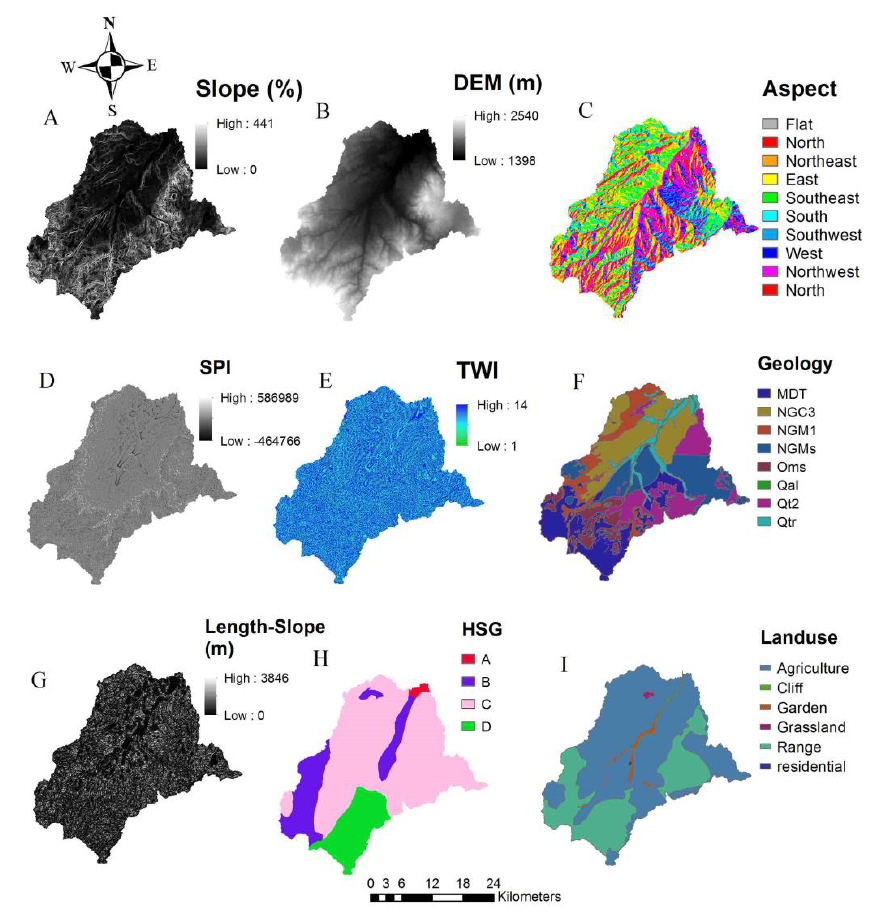
Figure 4. The prepared effective parameters on surface soil erosion. Each of these soil erosion conditioning parameters are discussed in the text.